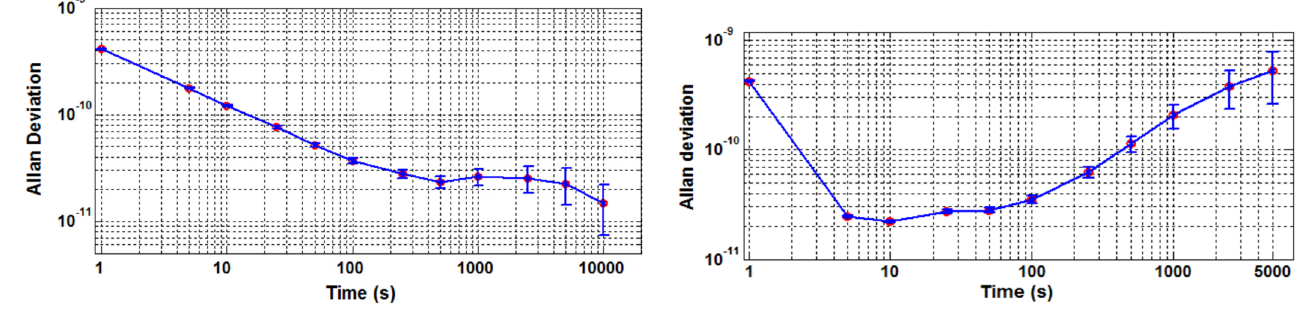
Fig. 8. Allan deviation of f beat note between HP5517D and femtosecond comb. Error bars corresponding to the standard uncertainty are shown for longer averaging times, where the error is large enough to be signi fi